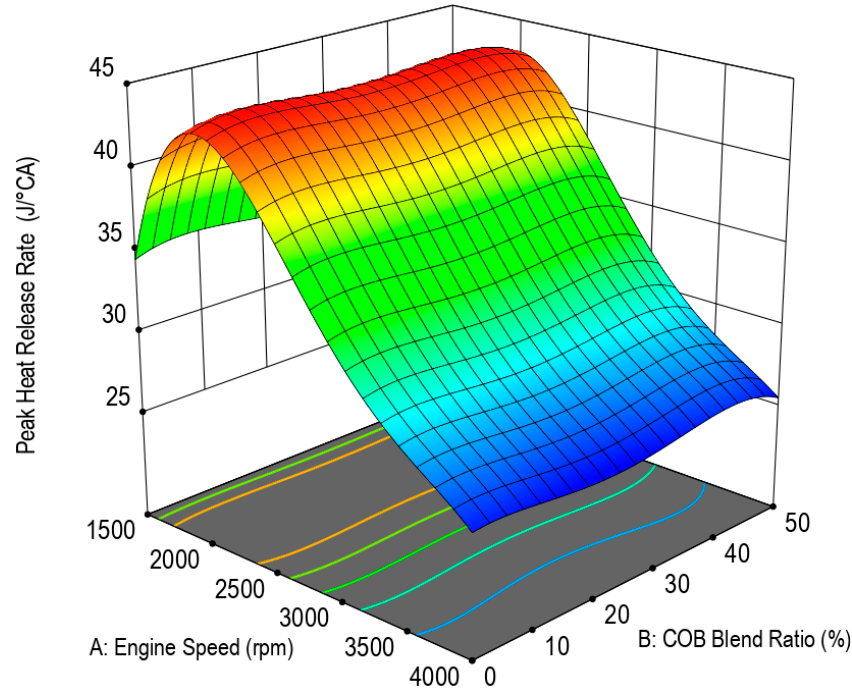
Figure 3. Peak heat release rate (PHRR) for various fuel blends at different engine